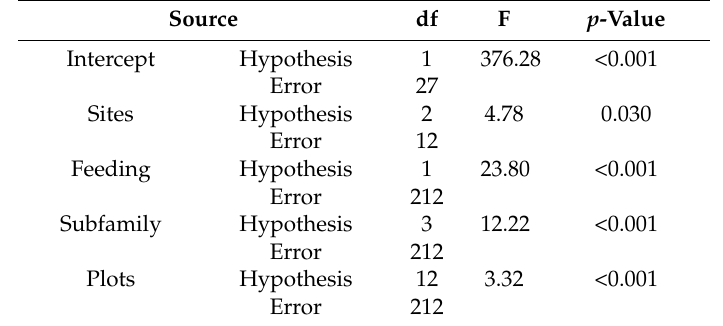
Table A5. Results of generalized linear models (GLM) that best fit the variation in isotope composition of δ 15 N in termites within tropical dry (cid:104)